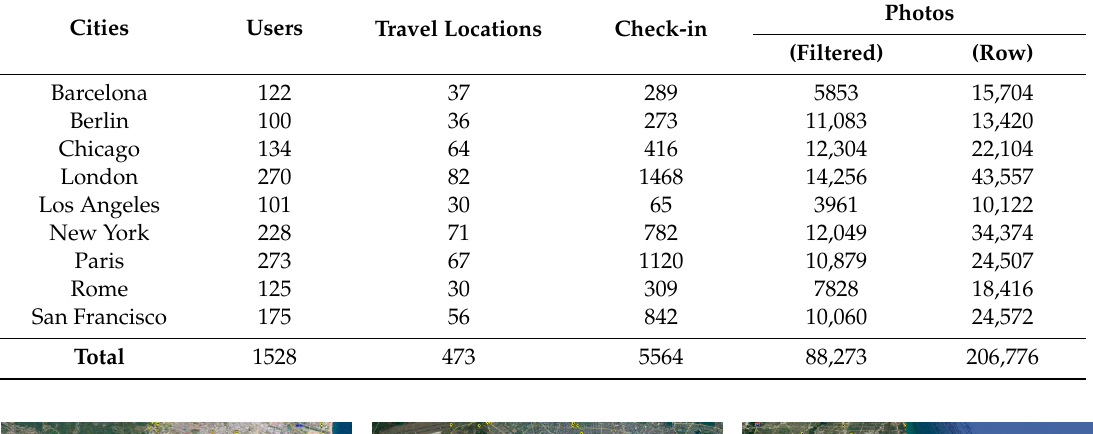
Table 2. Sample metadata of CCGPs; a few attributes are not given.